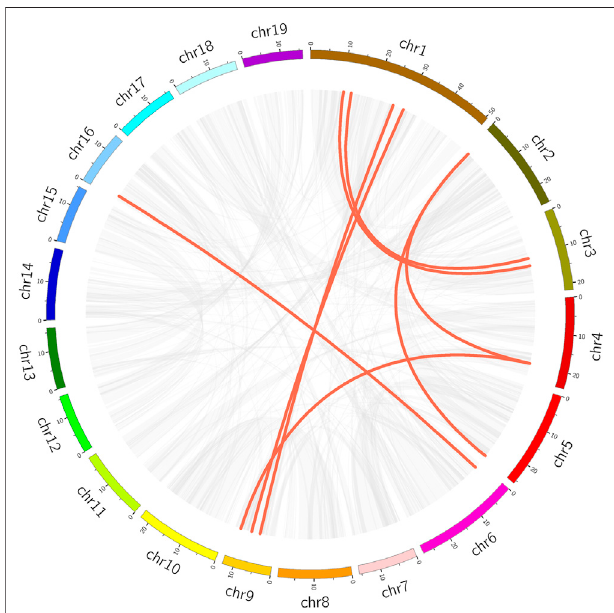
FIGURE 6 | Segmental duplication events of PtrMFS genes. Chr1 – 19 are represented by different colorful rectangles. Red lines represent collinear pairs of PtrMFS genes. Gray lines indicate collinear pairs in all poplar